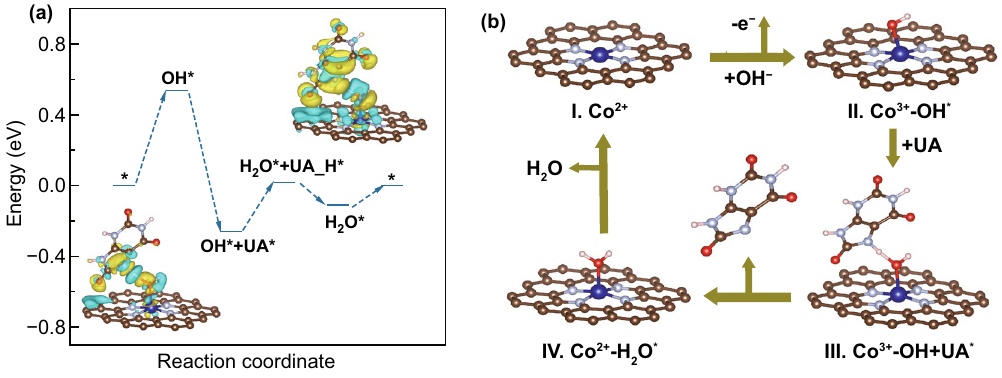
Fig. 5 a Gibbs free energy profile for the UA oxidation pathways on A–Co–NG nanozyme. Inset of a are the CDD isosurfaces of Co 3+ – OH + * UA before and after N–H bond dissociation (Co 2+ –H 2 O + * UA_H) under oxidation potential (UA_H represent the structure of UA molec- ular after dehydrogenation of one H atom). For the contour plots, the charge accumulation regions are rendered in yellow, while the charge depleted regions are shown in cyan. The contour value of the CDD is ± 0.02 e Å −3 . b Proposed mechanism of the oxidation process of UA